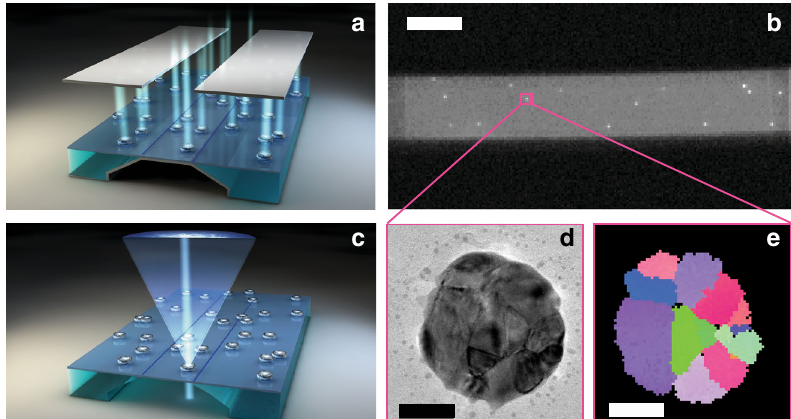
Fig. 1 Experimental platform. Plasmonic nanospectroscopy is combined with transmission Kikuchi diffraction ( TKD ) and transmission electron microscopy (TEM). a Artist ’ s rendition of the TEM-window platform with a Cr mirror layer grown beneath the membrane. This mirror layer enables multichannel single-particle plasmonic nanospectroscopy based on enhanced visible light back-scattering under dark- fi eld illumination conditions, using the slit of a spectrometer (indicated as the two dark rectangles ) to select the desired sample area. b CCD image through the spectrometer slit, showing a set of individual Pd nanoparticles as bright dots on the TEM membrane with Cr mirror underneath. Employing the slit to select a region on the sample, it becomes possible to image and spectroscopically address up to 10 single nanoparticles simultaneously, provided all are well-separated along the slit axis. The scale bar is 20 μ m. c Artist ’ s rendition of the TEM-window platform in “ electron microscopy mode ” after removal of the Cr mirror layer to enhance electron- transparency of the specimen. In TKD, using a state-of-the-art Bruker OPTIMUS TM detector, the electron beam enters the specimen from the backside and the detector collects the Kikuchi diffraction pattern in transmission mode. d TEM image and e corresponding TKD grain orientation map of a single Pd nanoparticle (see Fig. 5 for corresponding grain orientation legend), which can be directly correlated with the plasmonic nanospectroscopy experiment by identifying the same nanoparticles in both experiments. The scale bar is 50